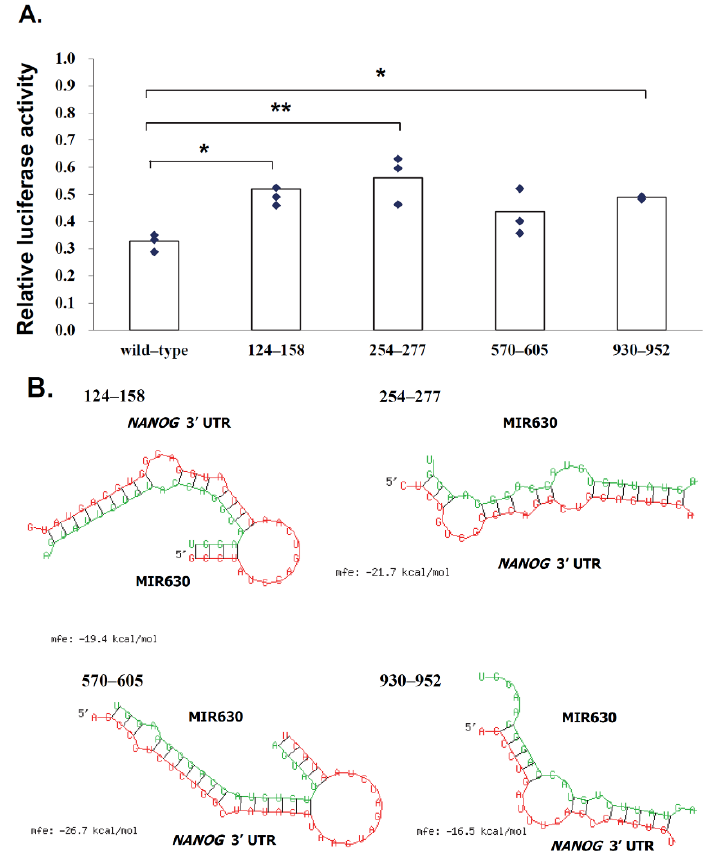
Figure 2. Mutations in the predicted MIR630 target sites exert significantly lower repression than wild-type reporter. ( A ). NT2/D1 cells were co-transfected for 24 h with negative control miRNA or MIR630 mimic and luciferase reporter containing wild-type and mutated NANOG 3 ′ UTR. Numbers 124–158, 254–277, 570–605, and 930–952 represent NANOG 3 ′ UTR positions. Cells were also cotransfected with pSV- β -galactosidase vector, and the β -galactosidase activity was used to normalize the luciferase activity. The relative luciferase activity is shown for reporter constructs containing wild-type 3 ′ UTR or mutated 3 ′ UTR in cells transfected with negative control miRNA or MIR630 mimic. Values were compared using one-way ANOVA and a post hoc test with Holm–Sidak, where * denotes p < 0.05 and ** denotes p < 0.01. ♦ represents data points. ( B ). Schematic representation of base pairing between putative NANOG 3 ′ UTR binding sites and MIR630. RNAhybrid model presents the most energetically stable complementary base pairing between MIR630 and NANOG 3 ′ UTR mRNA.